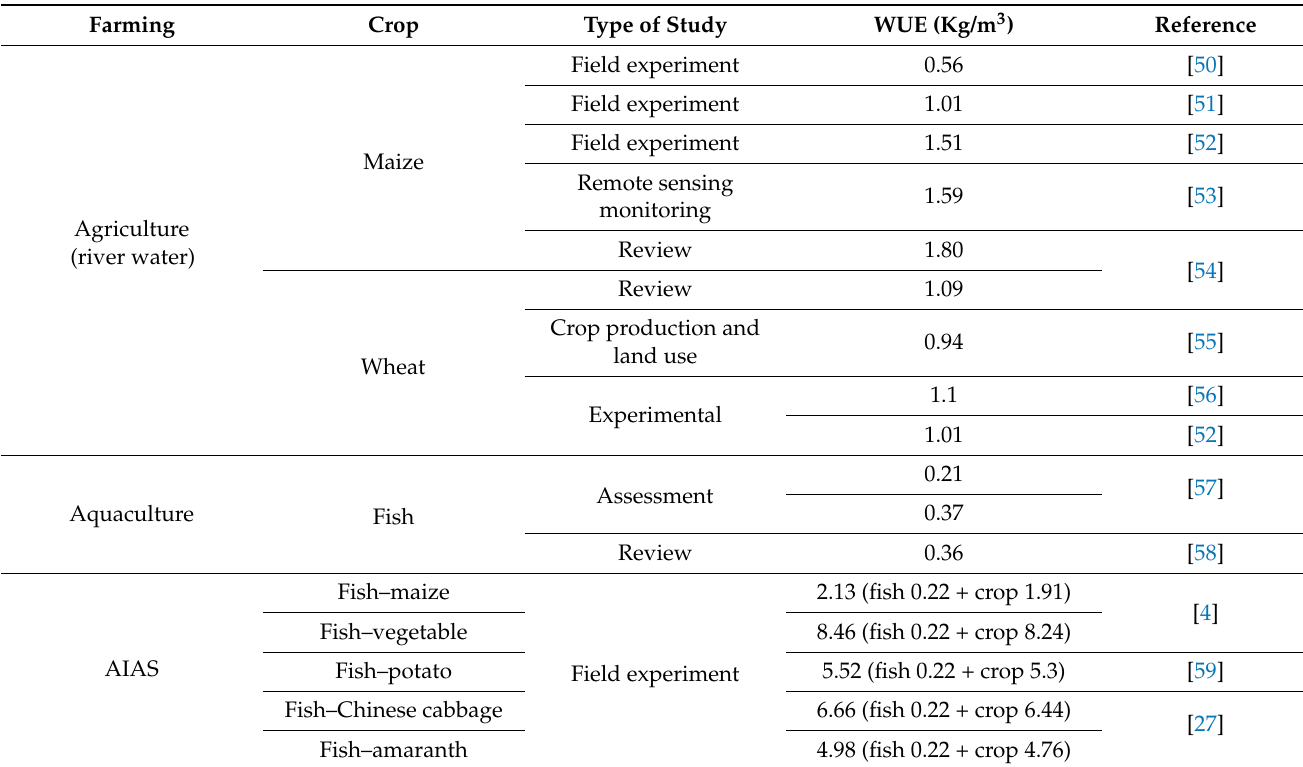
Table 7. Comparative WUE among crops under the different farming systems